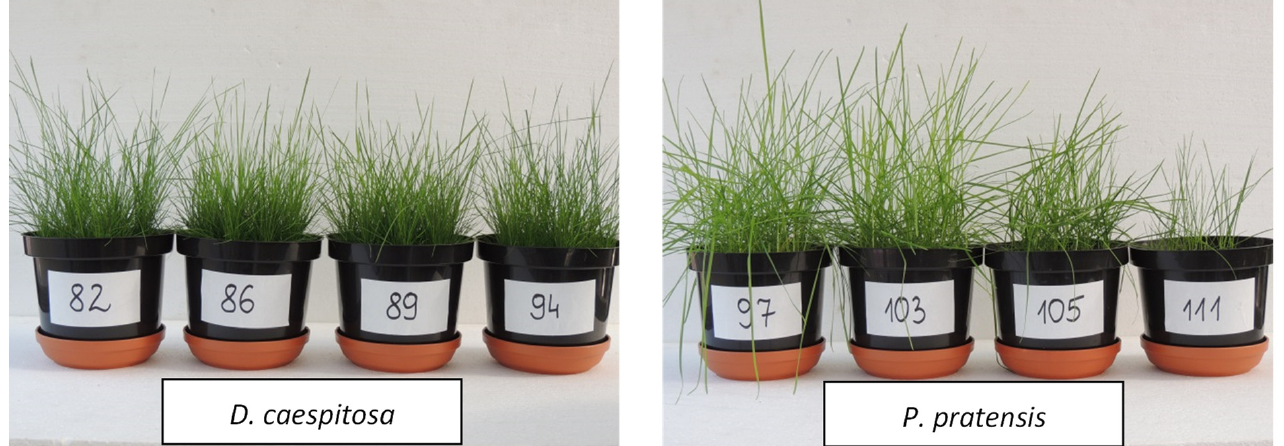
Figure 3. Grasses growing in zinc-contaminated soil. Pot number/Zn level: 82/0, 86/Zn1, 89/Zn2, 94/Zn3; 97/0, 103/Zn1, 105/Zn2, and 111/Zn3.